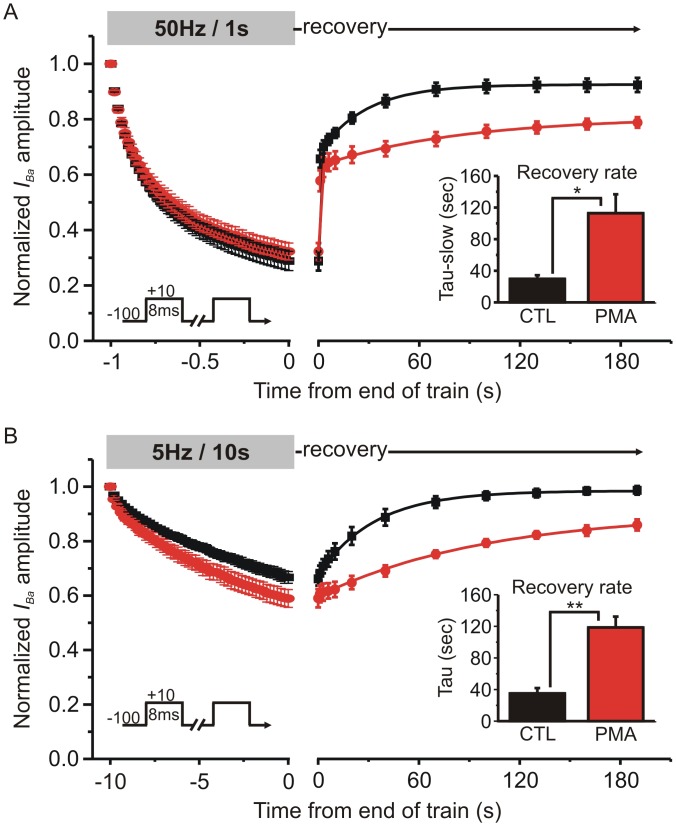
Recovery from “slow” inactivation following trains of brief stimuli was prolonged by PMA.
(A) HEK293 cells expressing CaV2.2, β1b and α2δ were stimulated with a train of brief (8ms) step depolarizations (50Hz for 1s) and recovery from inactivation was tracked at various time points as indicated. I
Ba amplitude was normalized to the first pulse of the stimulus train. The left panel shows the current decline (inactivation) during the stimulus train and the right panel shows the time-course of recovery following the train (note the change in scale on the X axis). Solid lines show double exponential fits to the mean recovery data (control: Y0 = 0.27, A1 = 0.39, A2 = 0.27, t1 = 0.38 s, t2 = 24.8 s: PMA Y0 = 0.31, A1 = 0.33, A2 = 0.16, t1 = 0.56 s, t2 = 68.8 s, comparison of fits F = 8.98 p = 0.001). The inset bar graph shows the mean time constant for the slower component of recovery calculated from fits to the individual cells (* p = 0.045 paired t-test, n = 4). (B) The same layout as panel A, except that the cells were stimulated using a 5Hz train lasting 10 s. Solid lines show an exponential fit to the mean recovery data (control: Y0 = 0.67, A = 0.30, t = 32.4 s; PMA Y0 = 0.60, A = 0.31, t = 106.8 s, comparison of fits F = 79.25 p < 0.0001). The inset bar graph shows the mean time constant for recovery calculated from fits to the individual cells (** p = 0.0042 paired t-test, n = 6).